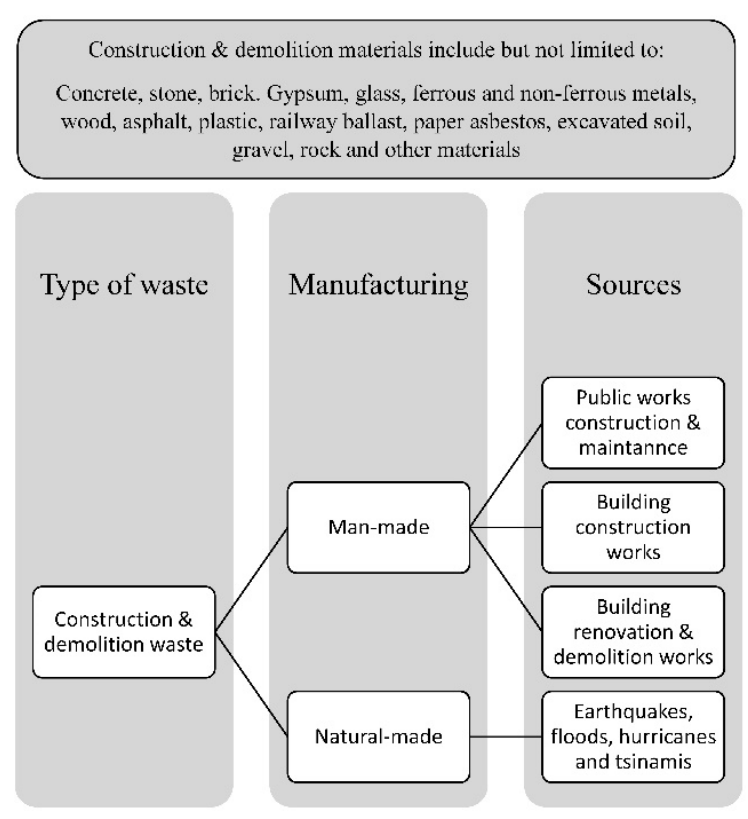
Figure 5. Construction waste types.